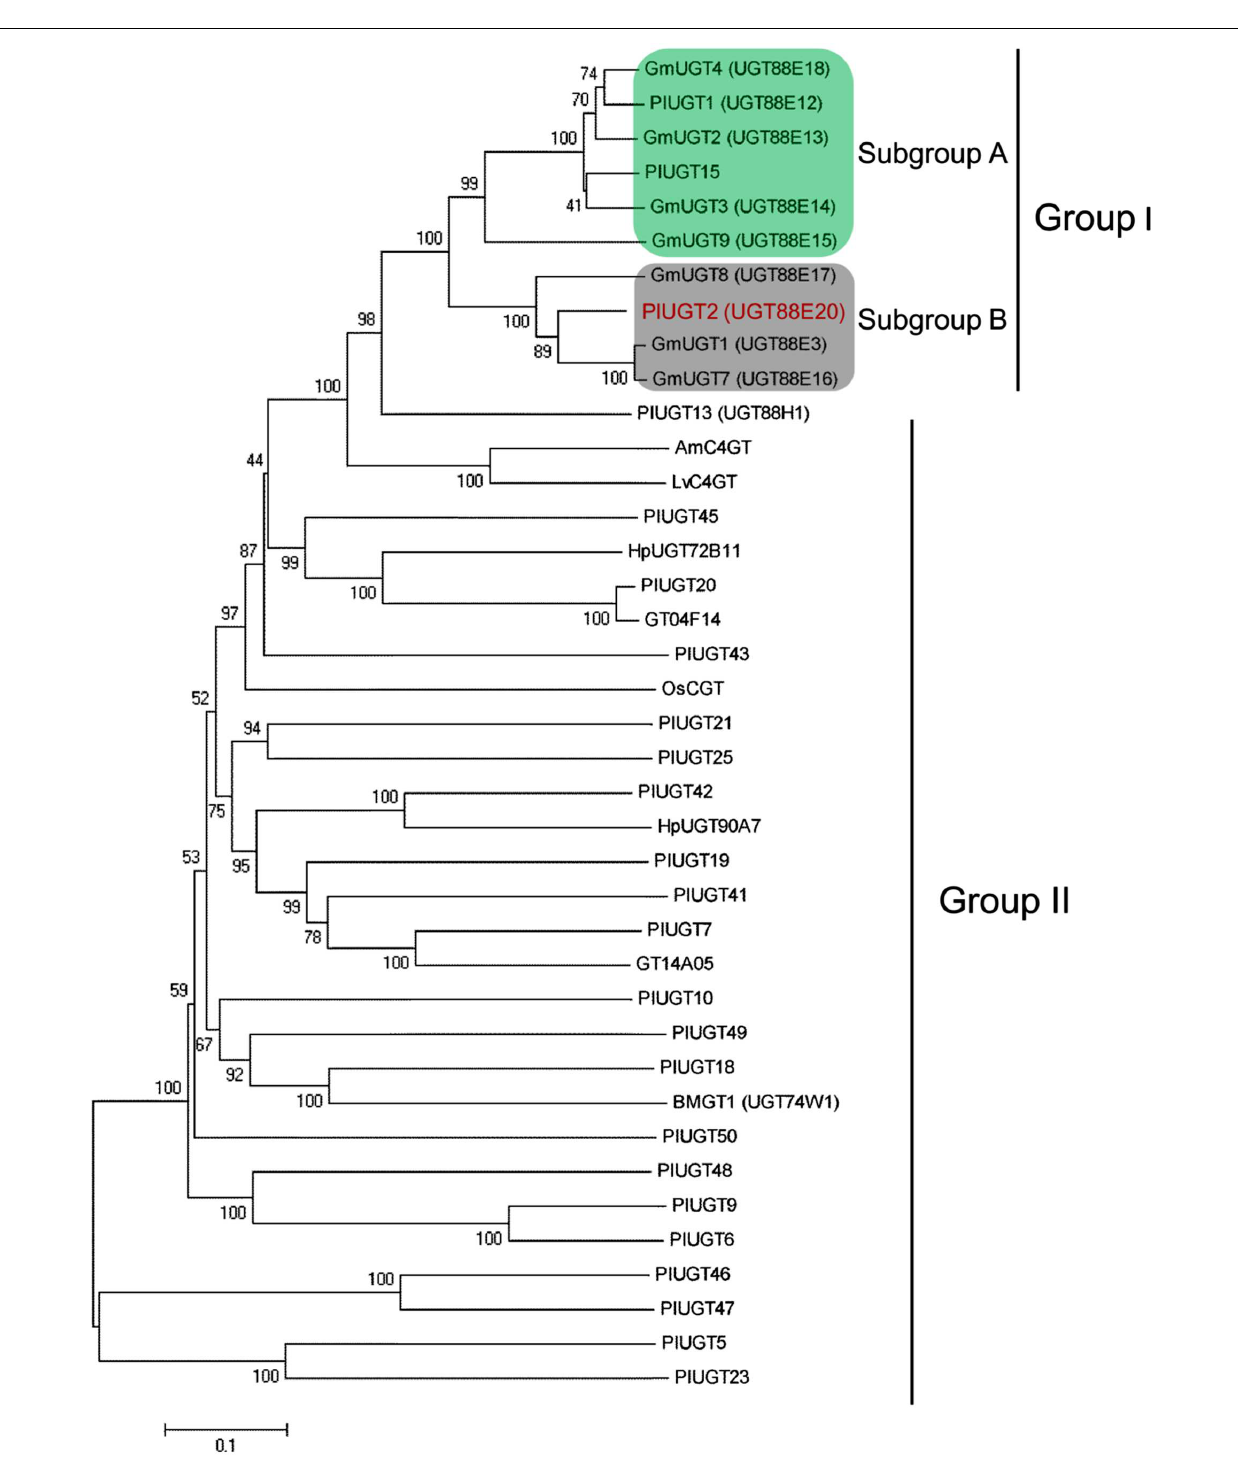
FIGURE 3 | Phylogenetic tree analysis of PlUGT2 with other known UGTs. Twenty two identified P. lobata family 1 UGTs were aligned with other plant UGTs whose functions have been characterized, including seven soybean UGTs and three kudzu UGTs. The tree was constructed from a MEGA 6.0 program using a neighbor-joining method (with 1000 bootstrap replications). Names and accession numbers of UGTs used for the alignment are as follows. AmC4’GT ( Antirrhinum majus UDP-glucose: chalcone 4 (cid:48) - O- glucosyltransferase, AB198665); BMGT1 ( Bacopa monnieri genistein 4 (cid:48) - O- glucosyltransferase, UGT74W1,